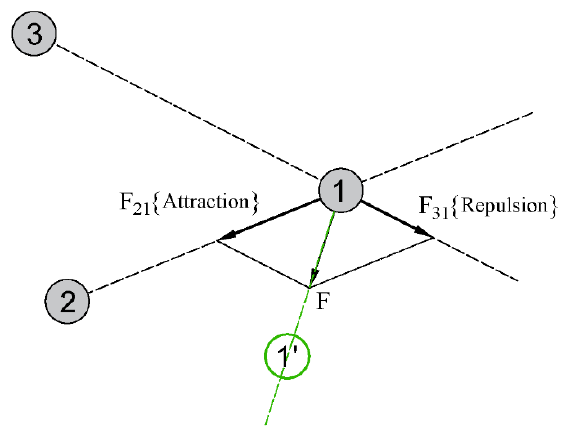
Figure 1. Schematic diagram of the mechanism of attraction and repulsion.